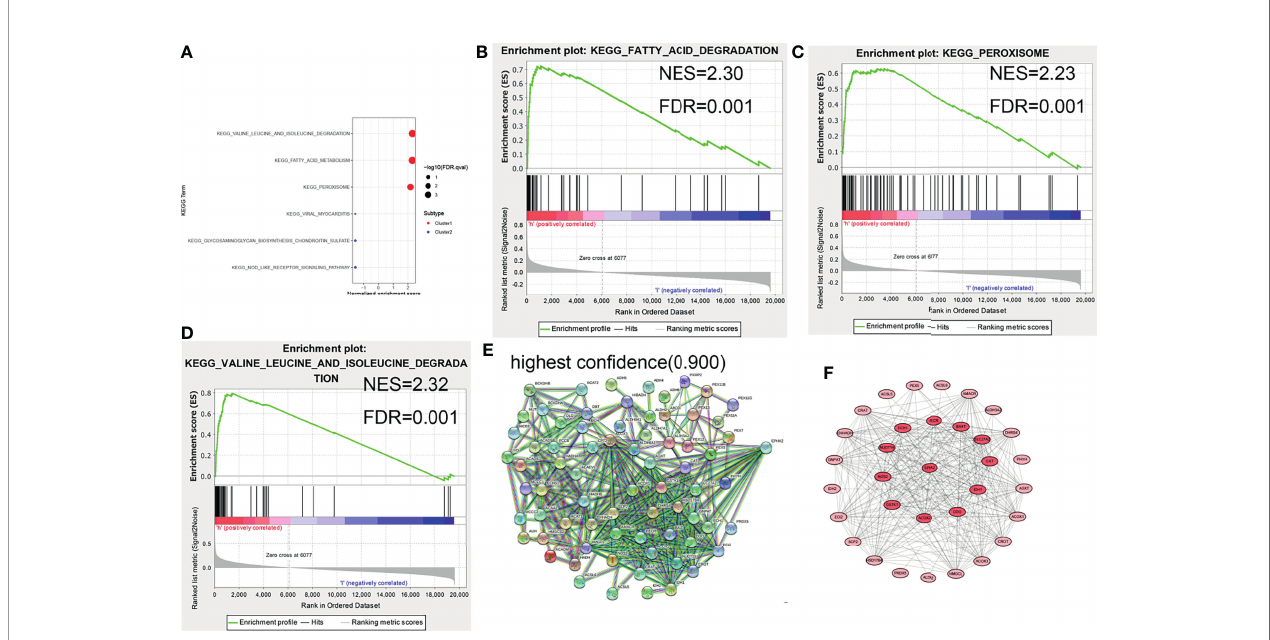
FIGURE 4 | GSEA enrichment analysis and protein interaction network of target genes. (A – D) Three optimal enrichment signaling pathways were screened according to NES >2 and FDR <0.001. (E) PPI analysis of enrichment pathway genes and target genes was performed using the String online tool (highest con fi dence: 0.9). (F) MCC was used to screen for core node, and EPHX2 was the fi rst target gene to appear in the core node (top 12).